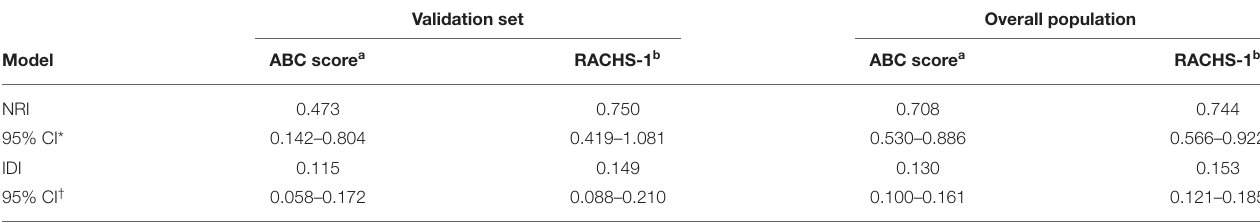
TABLE 3 | Improved model performance over the existing ABC score and RACHS-1